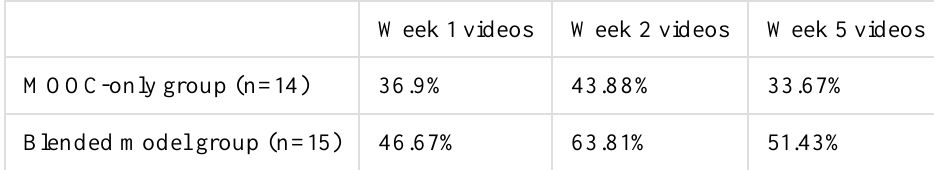
Percentage of Students who Watched Lecture Videos